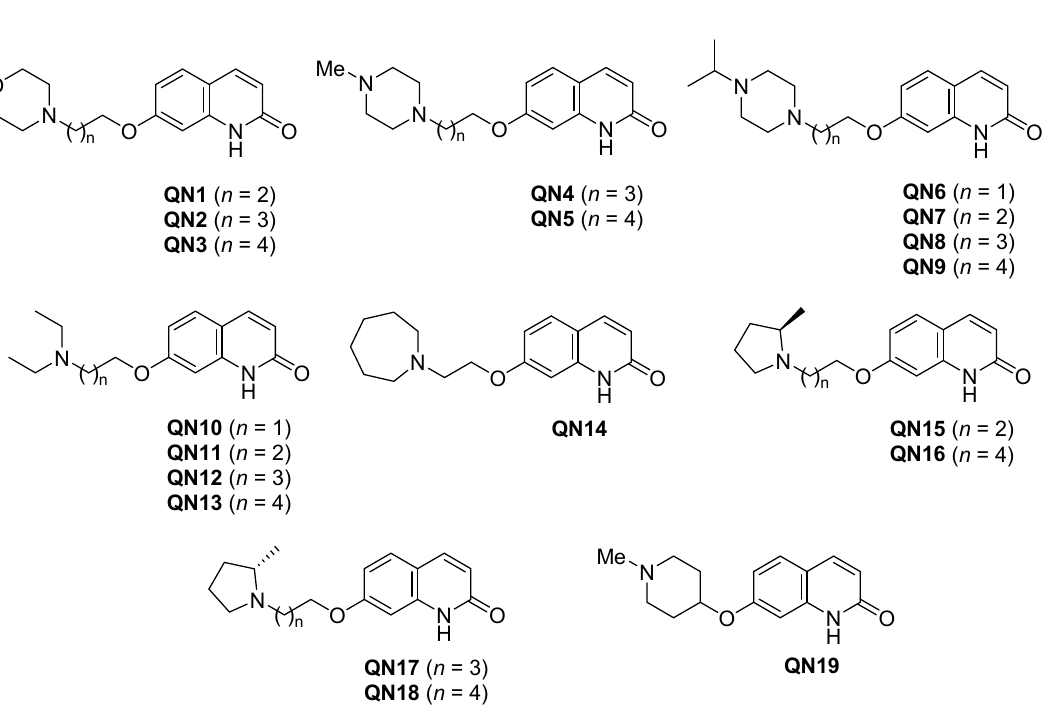
Figure 2. Structures of the “quinolinones” ( QN1 ‐ 19 ) described in this work.